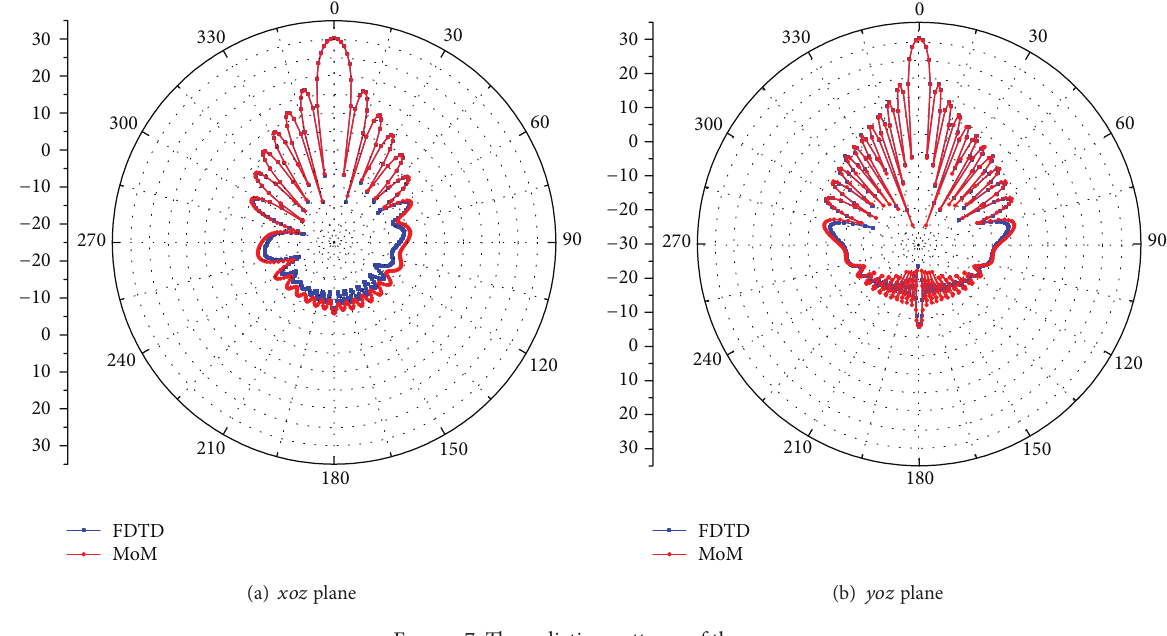
Figure 7: The radiation patterns of the array.